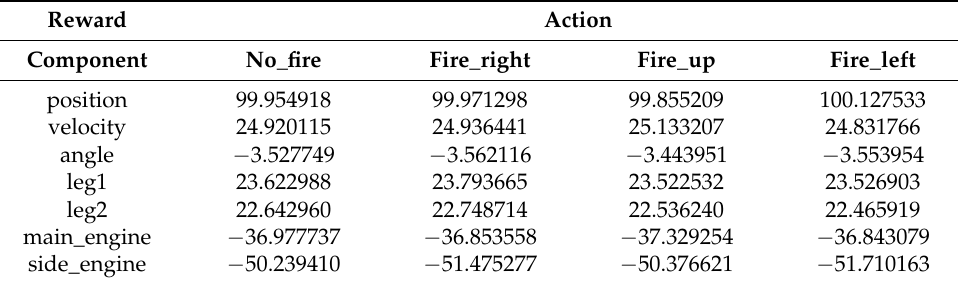
Table A6. Base values of the Lunarlander agent without reward